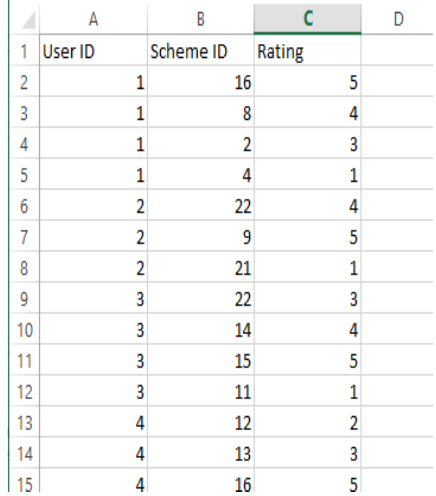
Figure 2. User Data Set